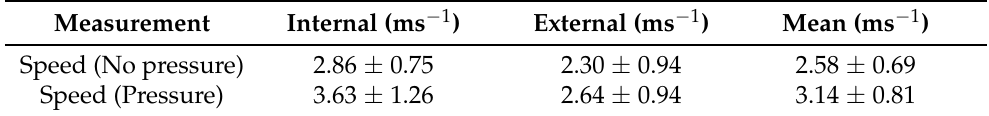
Table 4. Median (range) measurements of the shear-wave speed measured using the normal method for the internal and external regions of the cervix.